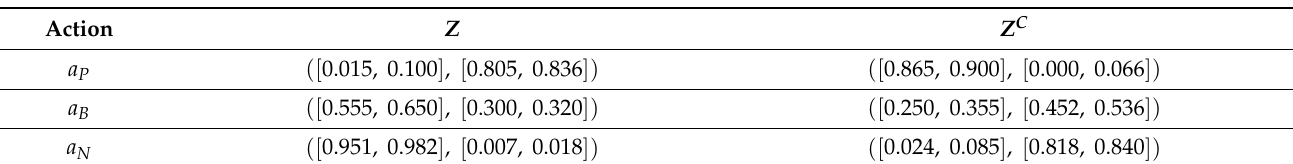
Table 13. Risk loss matrix results.